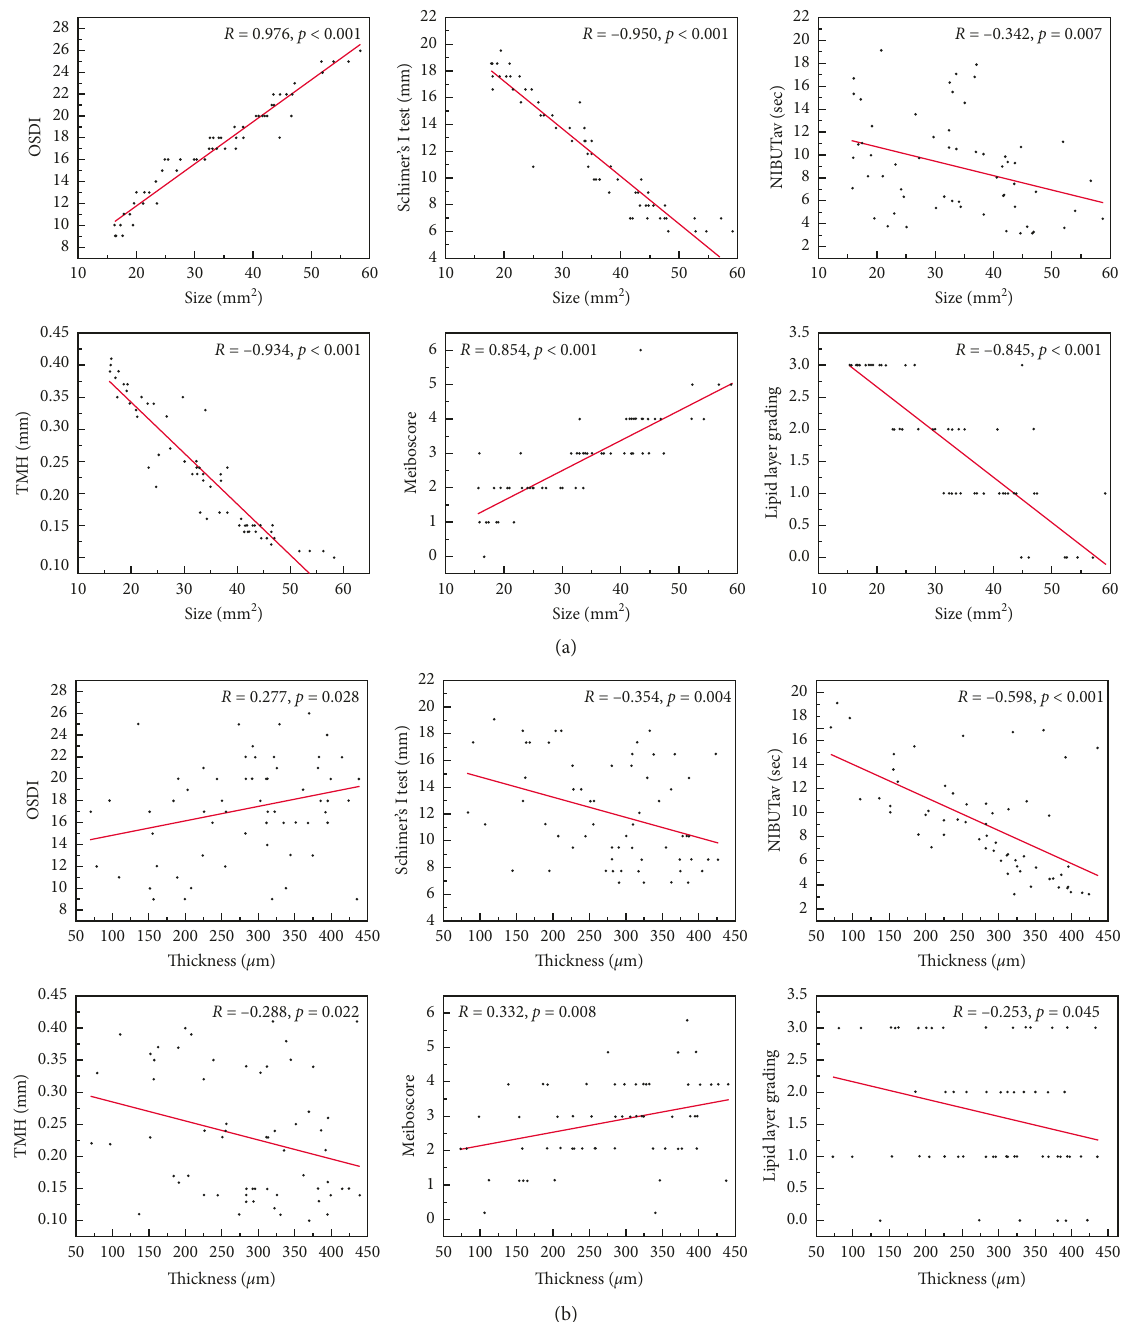
Figure 4: Correlations between pterygium size and thickness and various clinical indicators 1 month after surgery in patients with pterygium: (a) Pterygium size; (b) Pterygium thickness ( R , Pearson’s correlation coefficient, statistically